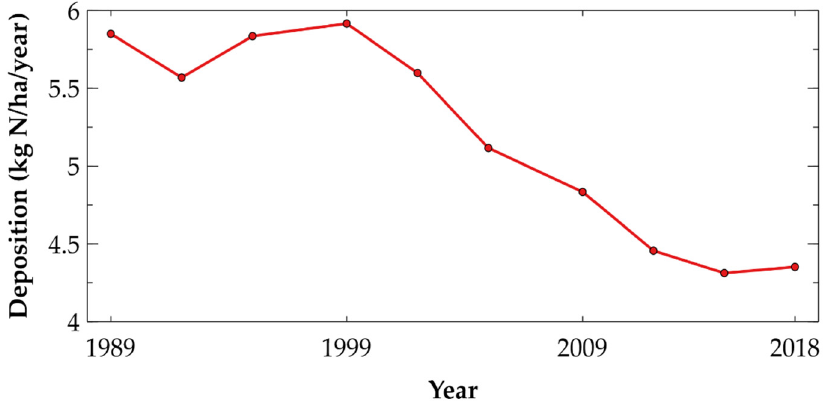
Figure 13. Atmospheric N deposition in the Low Mondego.